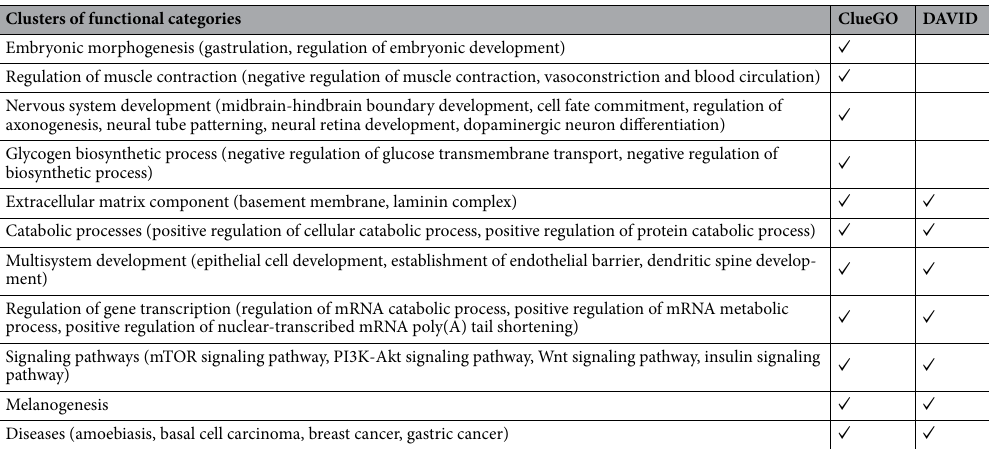
Clusters of functional